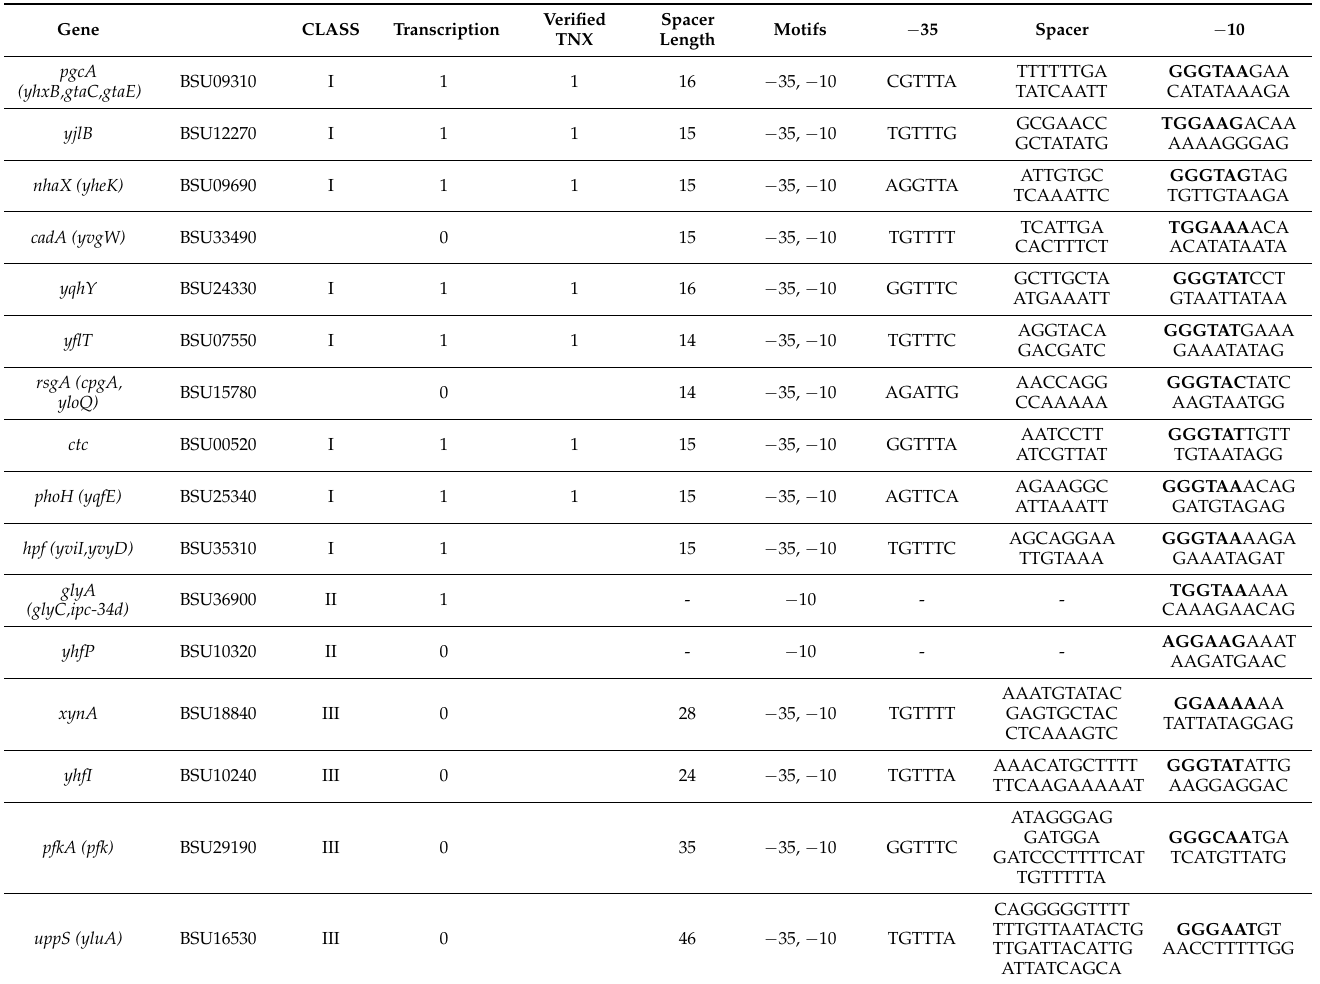
Table 1. Experimentally verified genes. Motifs − 35 and − 10, refer to the binding motifs as defined in Section 2.2. Gene CLASS Transcription Verified TNX Spacer Length Motifs − 35 Spacer − 10 pgcA